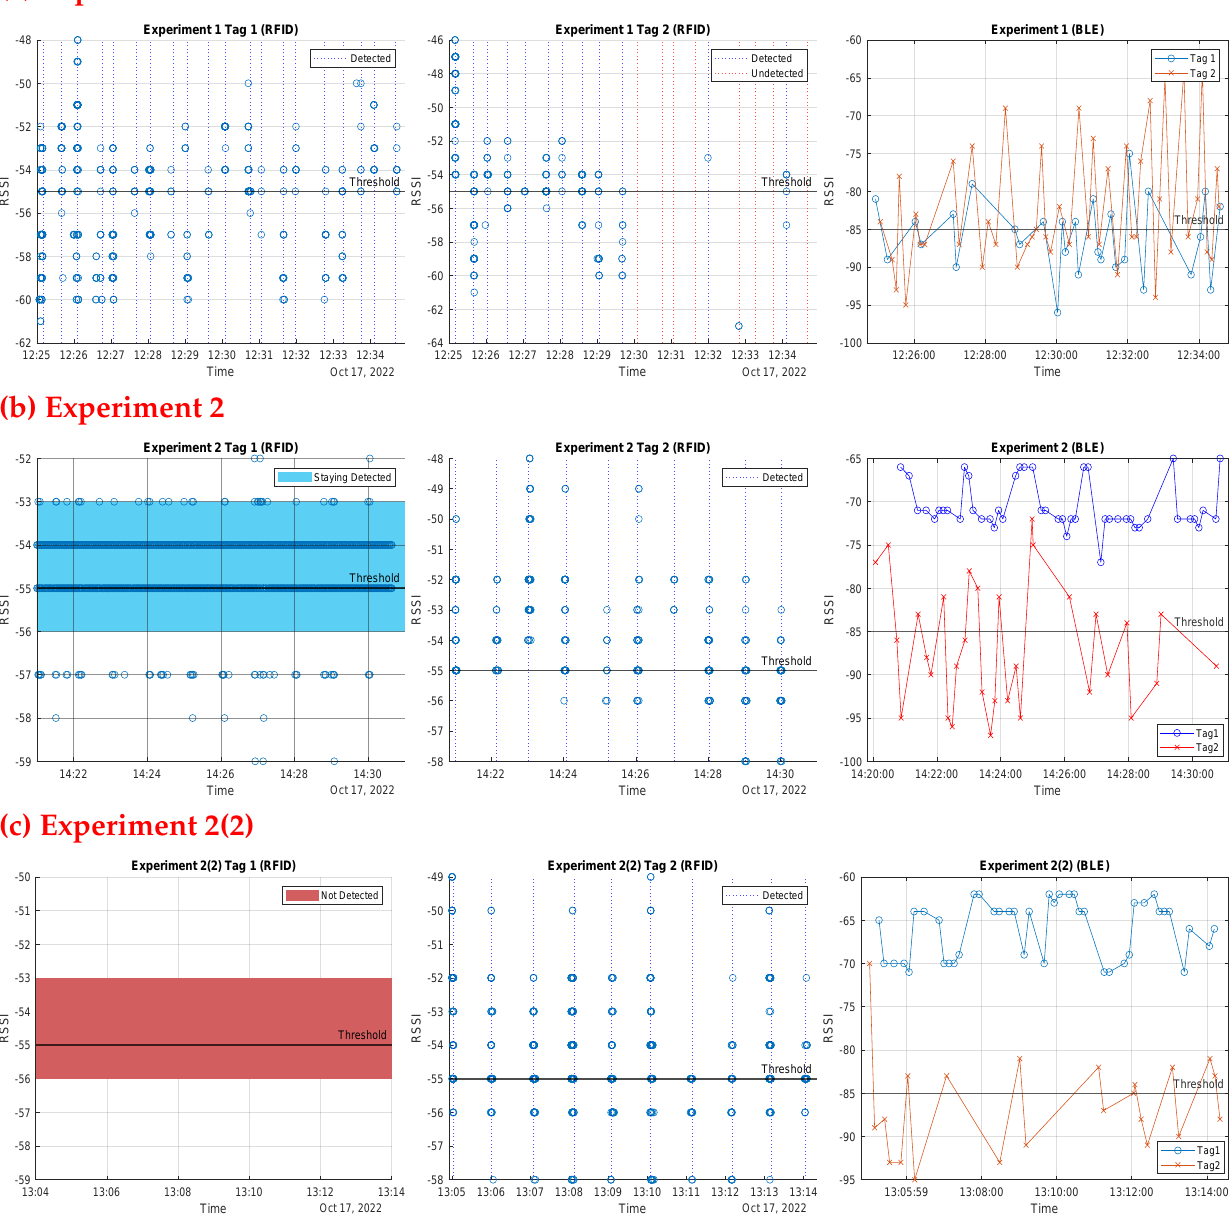
Figure 22. The first row shows the results of the first experiment of two tags entering and exiting together, the second row shows the results of the first trial of the second experiment of one tag exits and one tag stays, and the third row shows the results of the second trial of the second experiment. The first column represents the results of the first RFID tag, the second column represents the results of the second RFID tag, and the last column represents the results of the two BLE tags together in each experiment. In the first experiment, for RFID, the first tag is always detected (shown in blue dotted lines) while second tag has some missouts (shown in red dotted lines), the BLE system had some missouts as well. In the second experiment, for RFID, the first tag is always detected as staying (shown as blue region above threshold) while second tag’s exits were detected, also the BLE system worked fine detecting one tag always above threshold and the other tag is flactuating. In the second experiment rerun 2(2), for RFID, the first tag was not detected (shown in red region) while second tag’s exits were detected, the BLE system had the same performance as the second